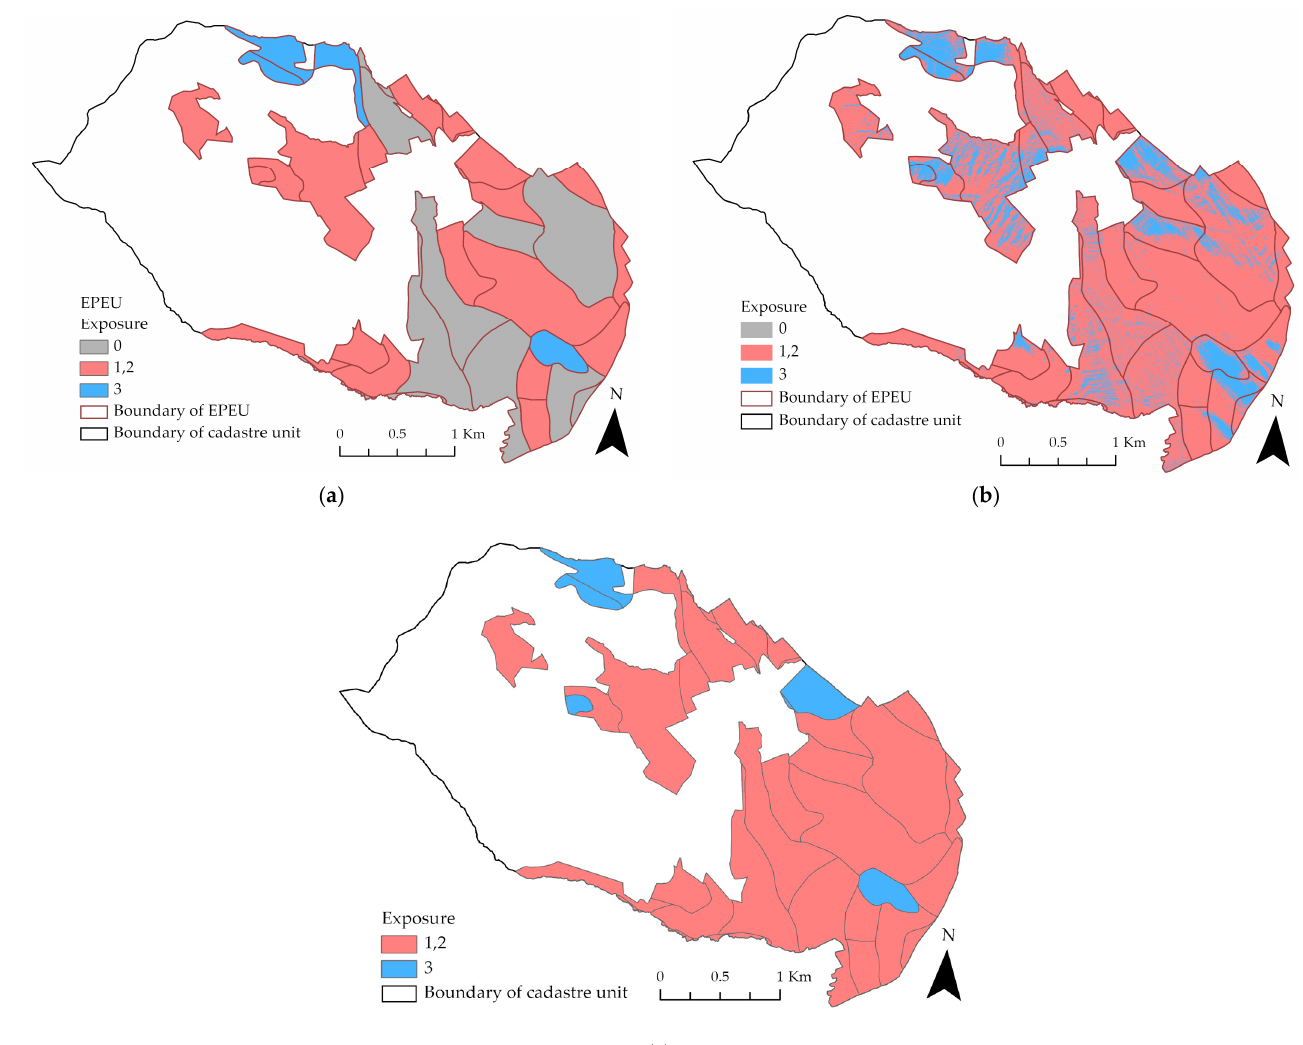
Figure 14. Exposure ( a ) by EPEU; ( b ) by DTM 5.0; ( c ) by histogram.